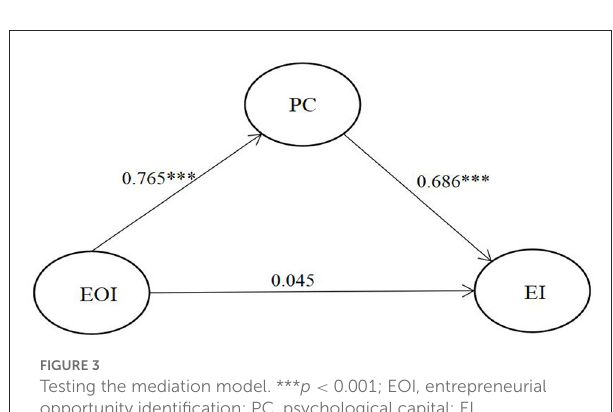
FIGURE3 Testing the mediation model. *** p < 0.001; EOI, entrepreneurial opportunity identification; PC, psychological capital; EI, entrepreneurial